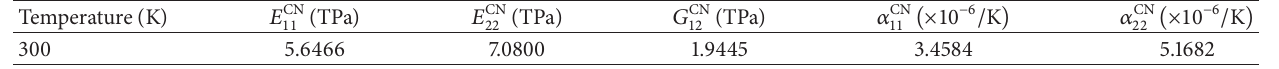
Table 1: Temperature-dependent material properties of single-walled carbon nanotubes [48].